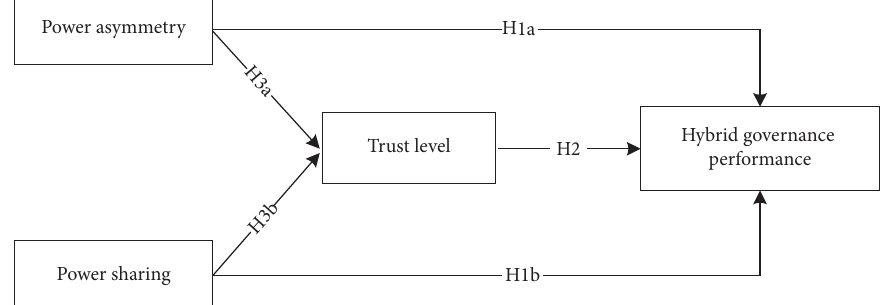
Figure 2: The study’s theoretical model of power and trust in hybrid